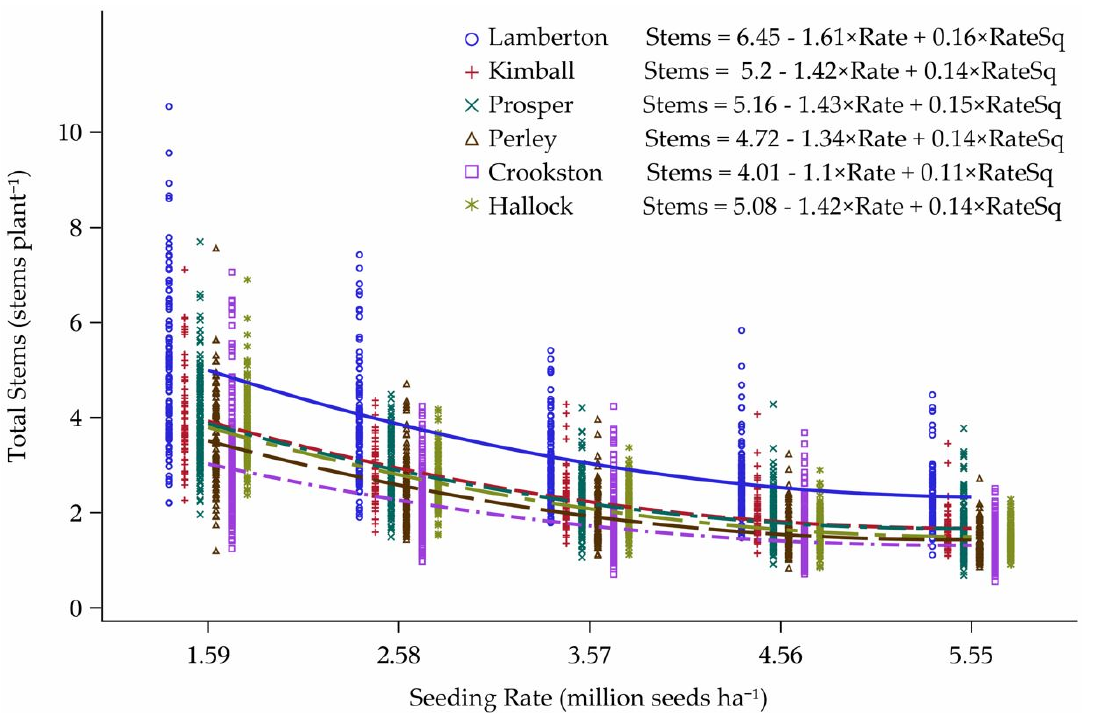
Figure 8. Tillering response curves to seeding rate for each location in Minnesota and North Dakota, 2013–2015.